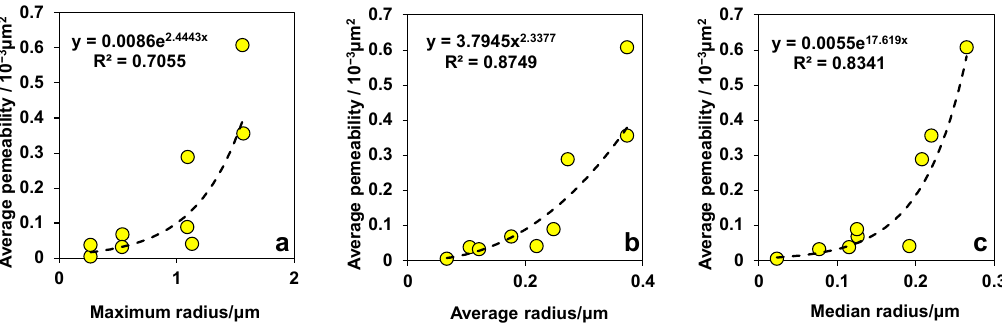
Figure 3. Correlation analysis between pore throat radius and permeability in tight oil reservoirs.